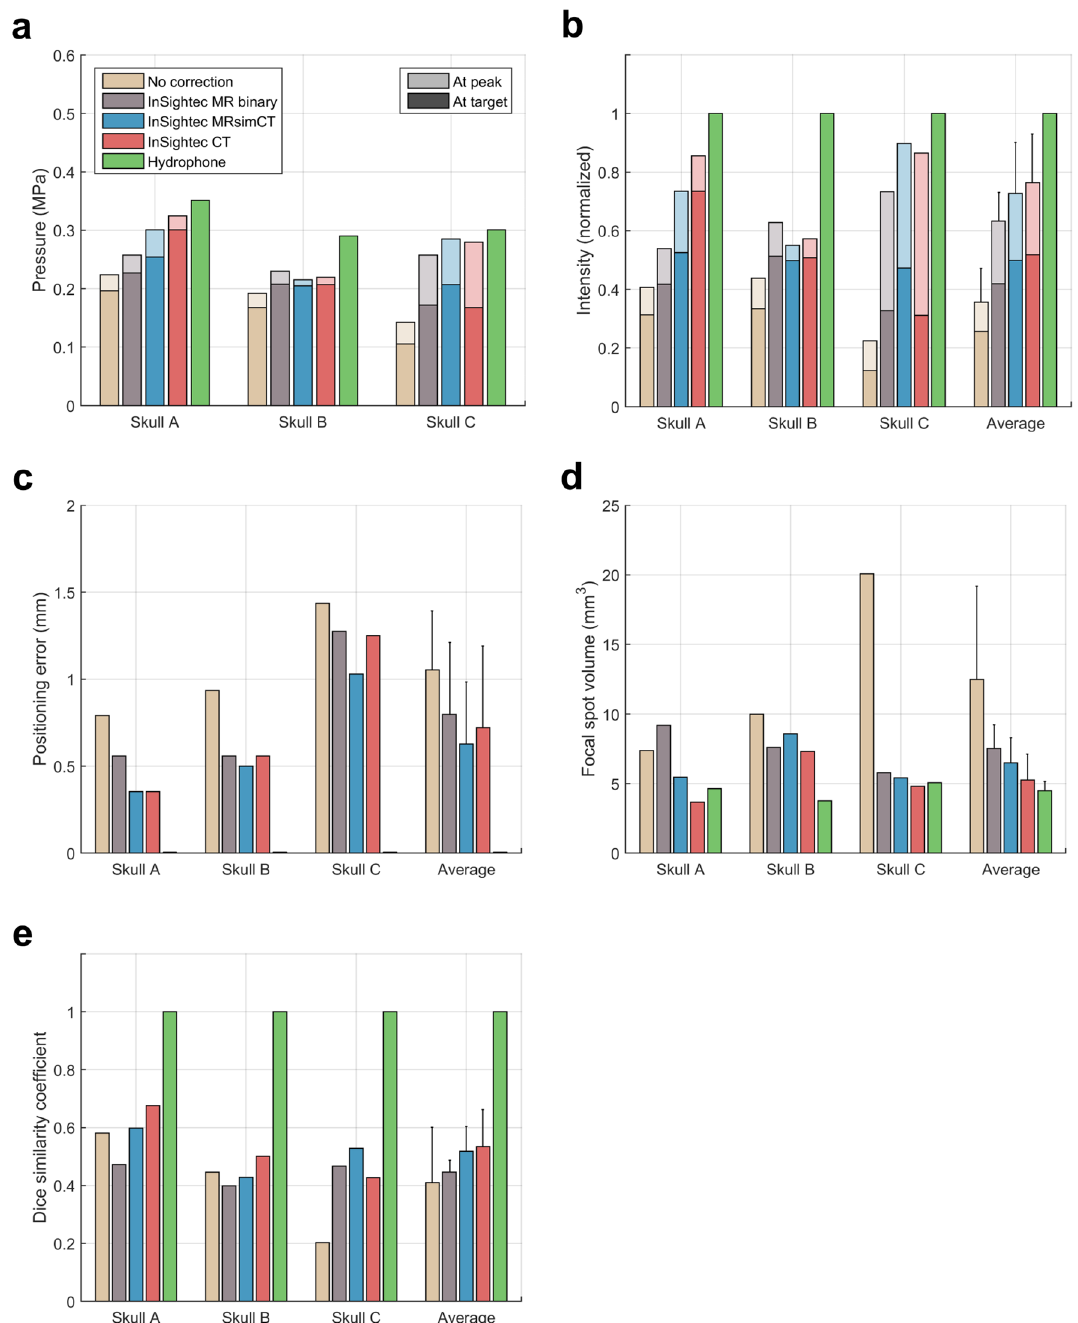
Figure 5. Beamforming performance of different image types with the target placed at the geometric focus. ( a ) Target and peak pressure (shown with darker and lighter colors, respectively) when operating the transducer at 20 W of electrical power. ( b ) Target and peak intensity normalized to the hydrophone method. ( c ) Focal spot positioning error. ( d ) Focal spot volume. ( e ) Dice similarity coefficient. Standard deviation bars are